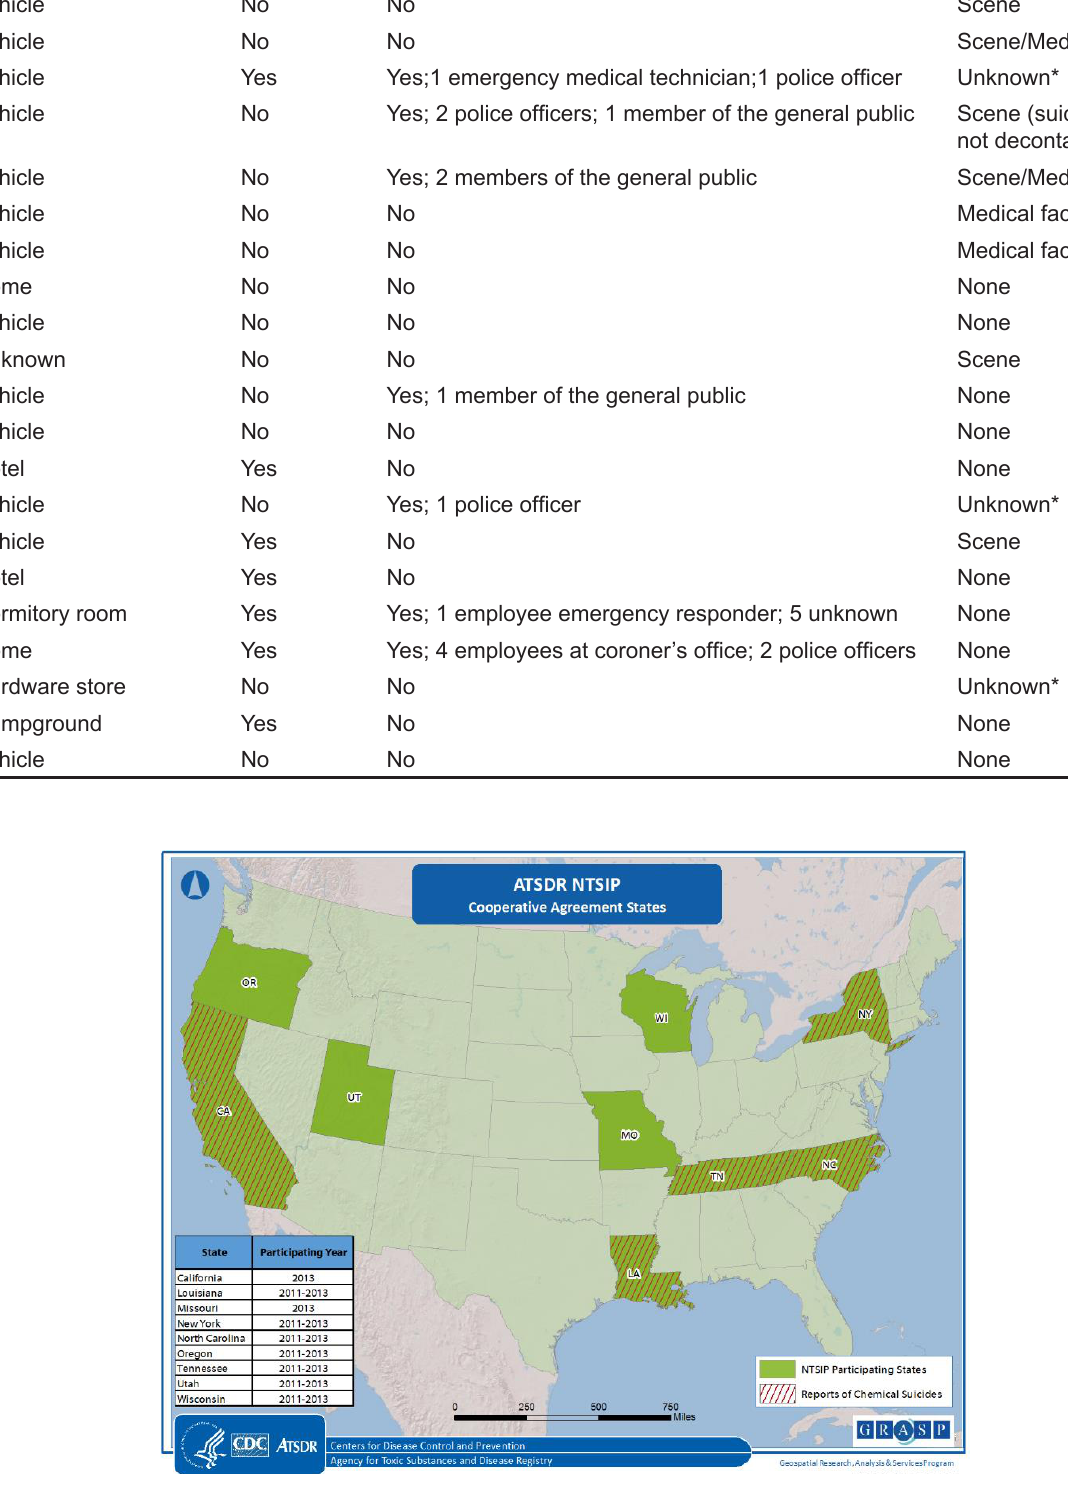
Figure. Participating National Toxic Substance Incidents Program (NTSIP) states and states reporting chemical suicides, NTSIP